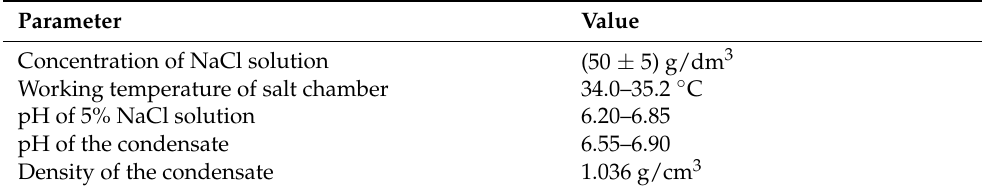
Table 1. Parameters of the salt chamber experiment.